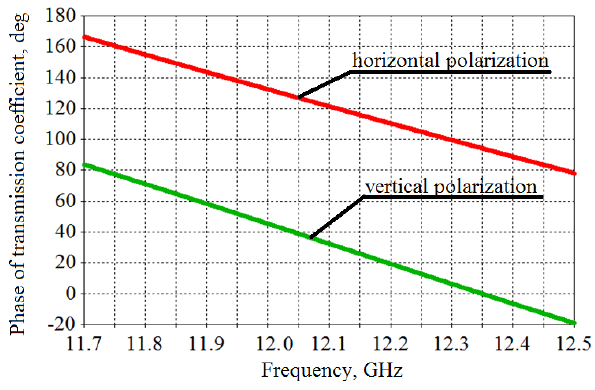
FIGURE 9. Dependences of phase of the transmission coefficient on frequency for horizontal and vertical polarizations calculated by the numerical